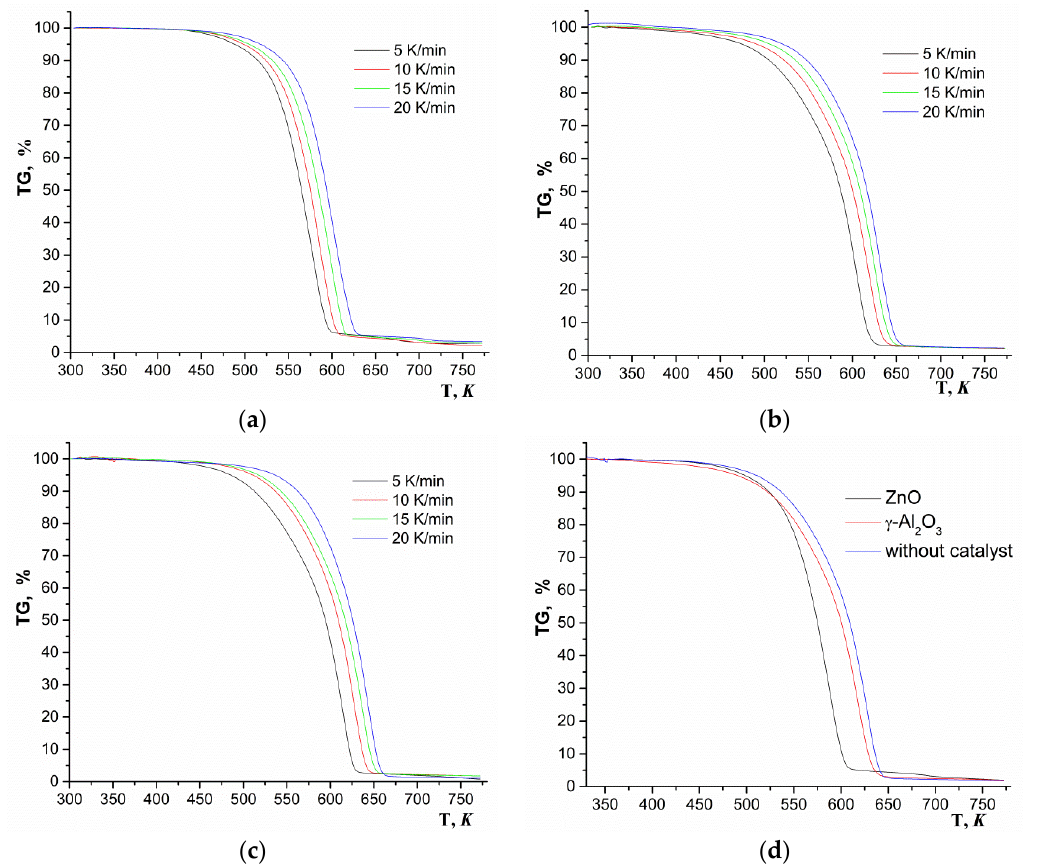
Figure 5. TG-curves of depolymerization of GAO:LAO mixture in the presence of catalysts and without them: ZnO ( a ), γ -Al 2 O 3 ( b ), without catalyst ( c ), all systems at the heating rate 10 K/min ( d ).